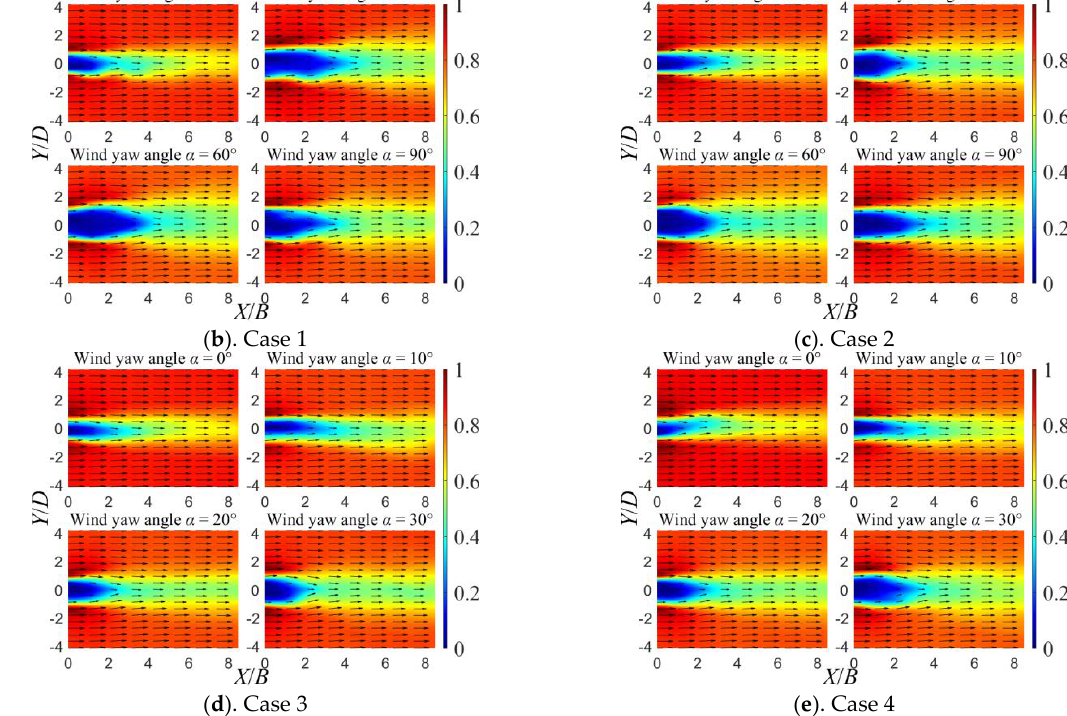
Figure 5. Dimensionless area of low-speed region.